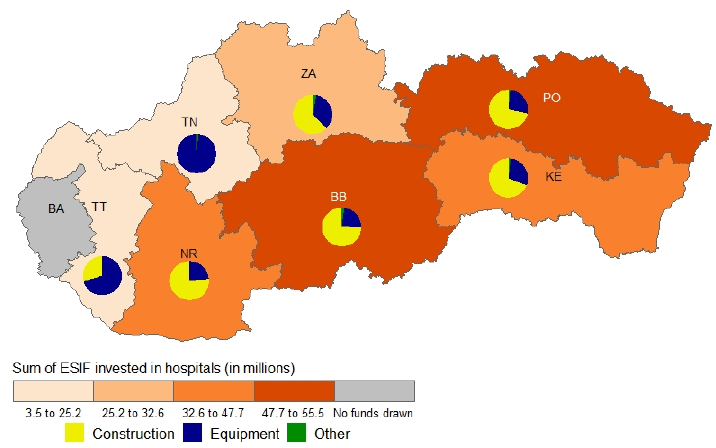
Figure 3: ESIF invested in hospitals (in millions of Euros) and breakdown by type of